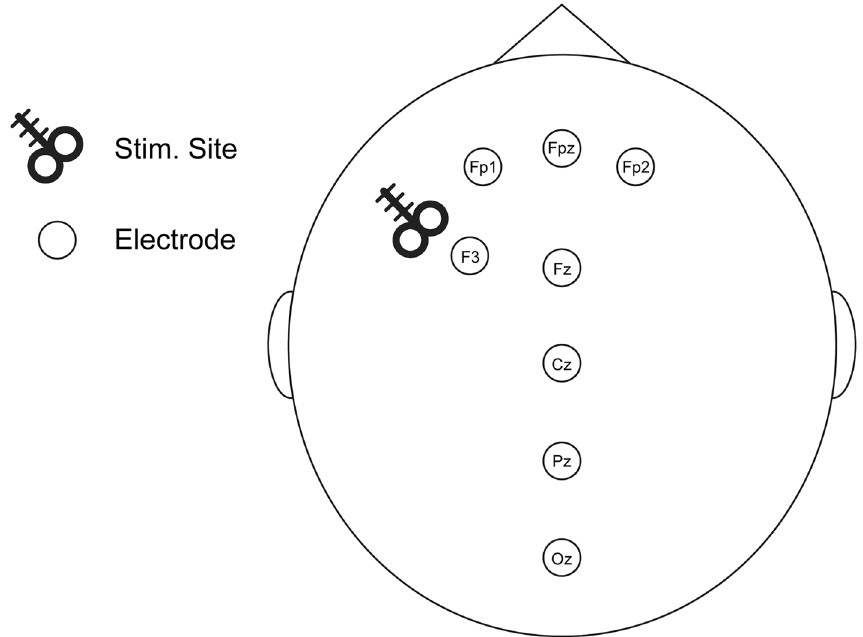
Figure 1. EEG electrode placement and TMS stimulation site. Locations of 8 electrodes, including the stimulation site targeting the left DLPFC (over